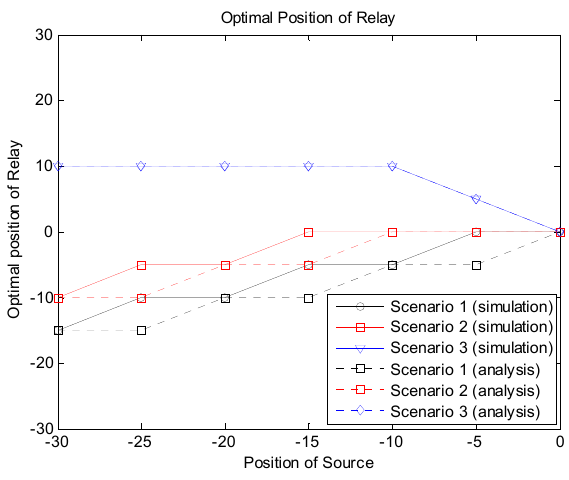
Figure 12. Optimal relay position.